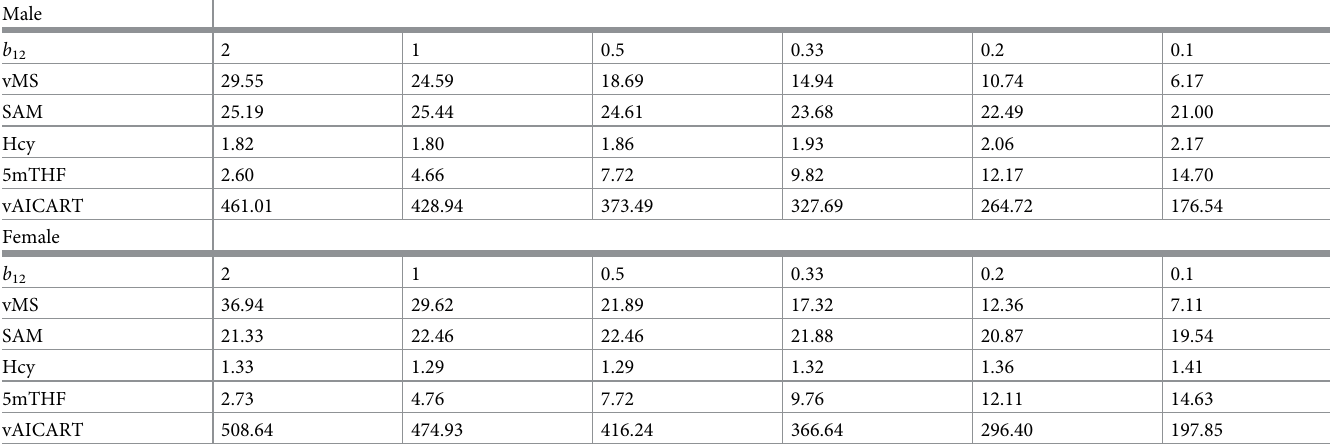
Table 2. The effects of B 12 deficiency in males and females in the